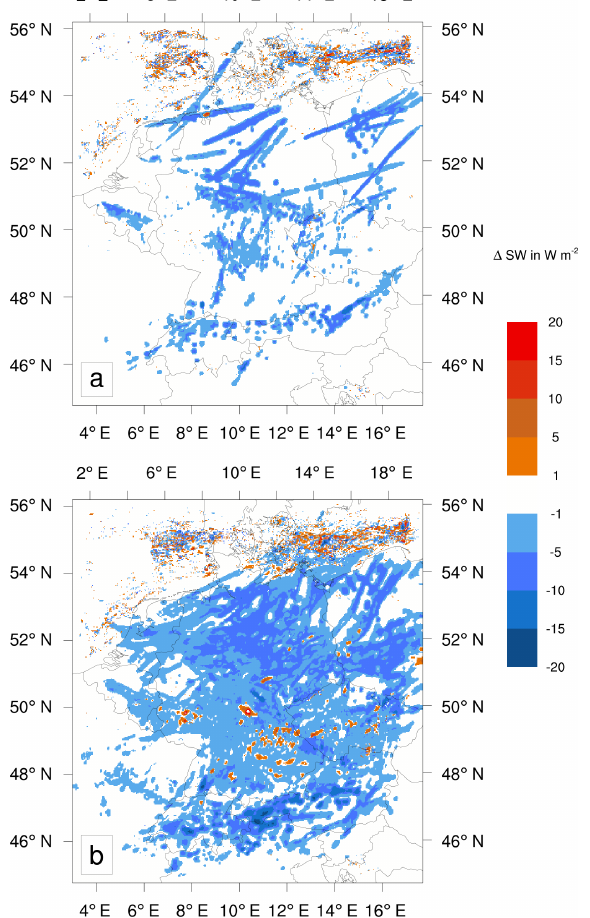
Figure 11. Difference in shortwave incoming radiation for aviation simulation and reference simulation for 3 December 2013 at the surface: (a) 10:00UTC; (b) 12:00UTC.